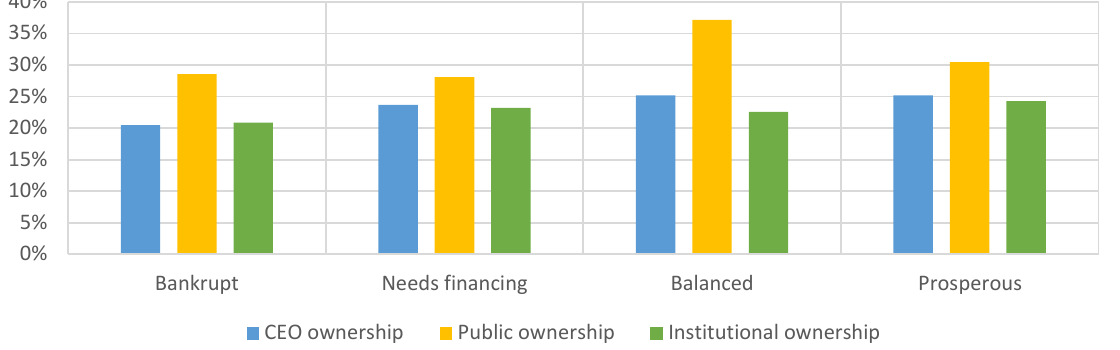
Figure 3. Average ownership percentages for each of the final states